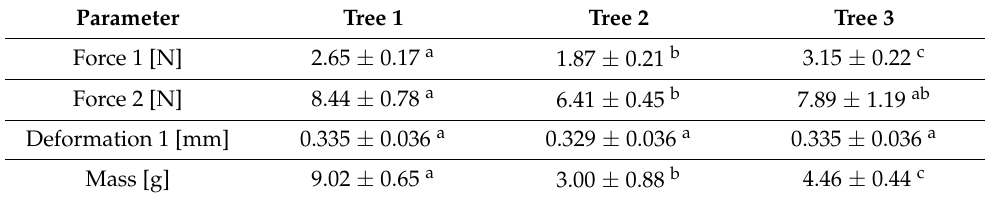
Table 1. Selected mechanical parameters and an average mass of acorns from three oak